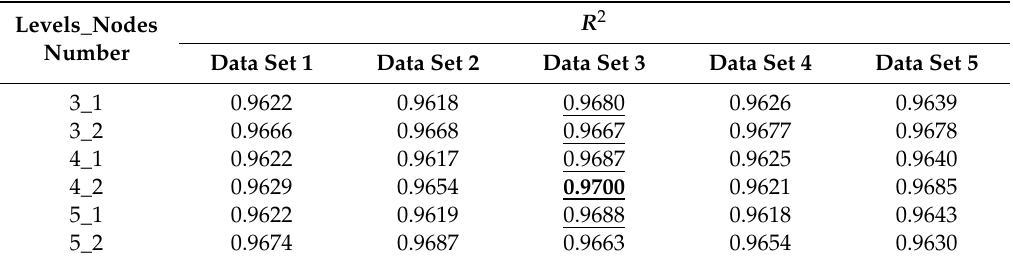
Table 5. Testing analysis for FCM clustering.